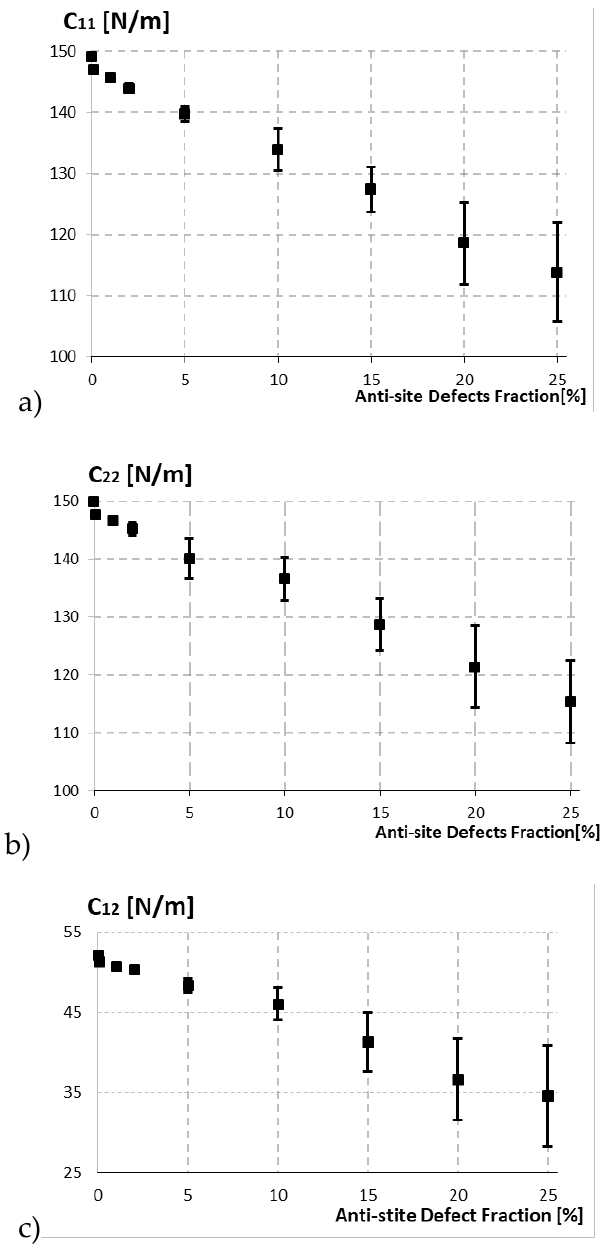
Figure 6. The elastic constants of MoS 2 as a function antisite defect fraction: ( a ) C 11 , ( b ) C 22 , ( c ) C 12